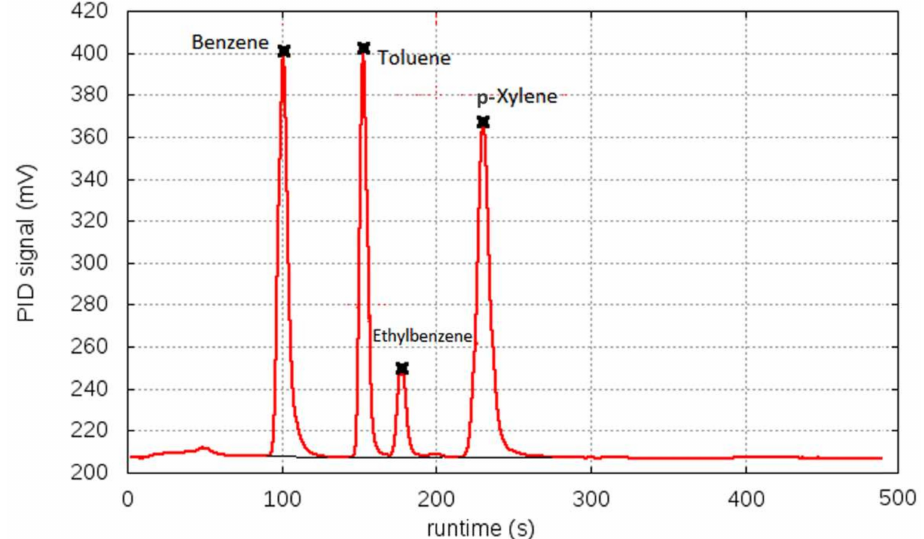
Figure 2. Example of MEMS mini-GC chromatogram, showing PID signal versus elution time. Sampling performed at 50% RH.